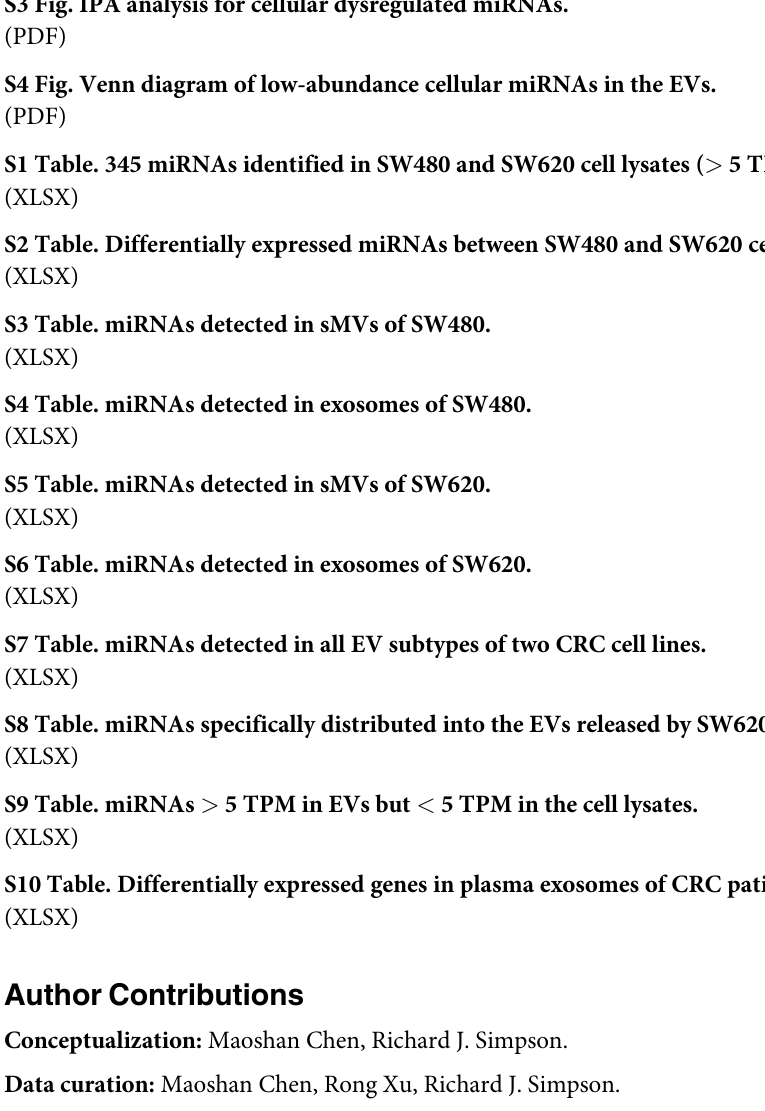
S3 Fig. IPA analysis for cellular dysregulated miRNAs. S4 Fig. Venn diagram of low-abundance cellular miRNAs in the EVs.